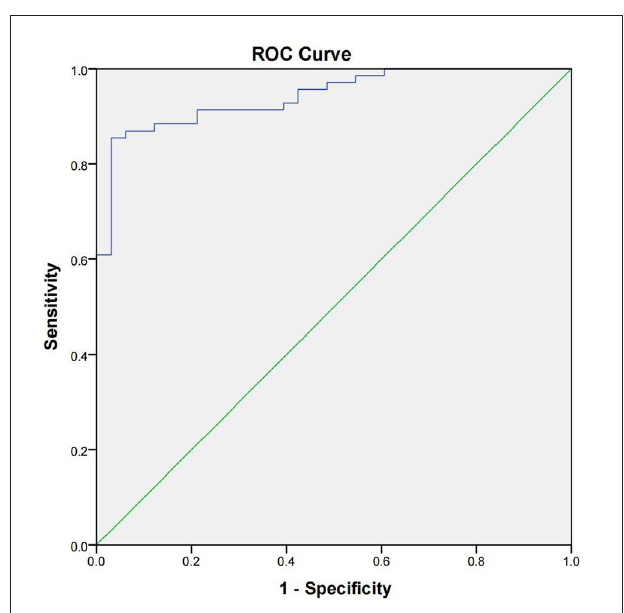
FIGURE 5 | The receiver operating characteristic curve of the lateral flow immunoassay with the SAT method as state variable. The area under the curve (AUC) was 0.942 (95% CI, 0.900–0.984); the standard errors (under the non-parametric assumption) were 0.022, p <